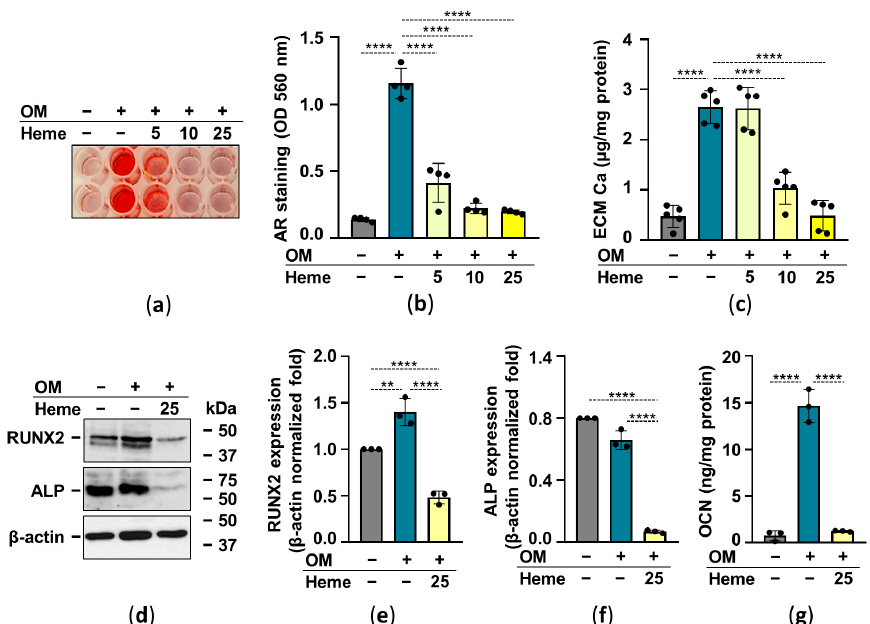
Figure 4. Heme inhibits OM-induced ECM calcification of HuLECs. ( a – g ) Confluent HuLECs (pas- sage number 5–8) were treated with Ctrl, OM, and OM + heme as indicated. ( a , b ) Dose-dependent effect of heme (5, 10, 25 µmol/L) on OM-induced Ca deposition in the ECM evaluated by AR staining (day6). Representative images and quantification from 4 independent experiments are shown. ( c ) Ca content of the HCl-solubilized ECM (day6). Data points represent independent experiments. ( d – f ) Protein expressions of Runx2 and ALP were determined from whole-cell lysates (day6). Mem- branes were re-probed for β -actin. ( d ) Representative Western blots (n = 3). ( e , f ) Relative expressions of Runx2 and ALP normalized to β -actin are shown. ( g ) OCN level in EDTA-solubilized ECM (day6) from 3 independent experiments. Data are expressed as mean ± SD. Ordinary one-way ANOVA followed by Tukey’s multiple comparison test was used to obtain p values. ** p < 0.01, **** p < 0.001.